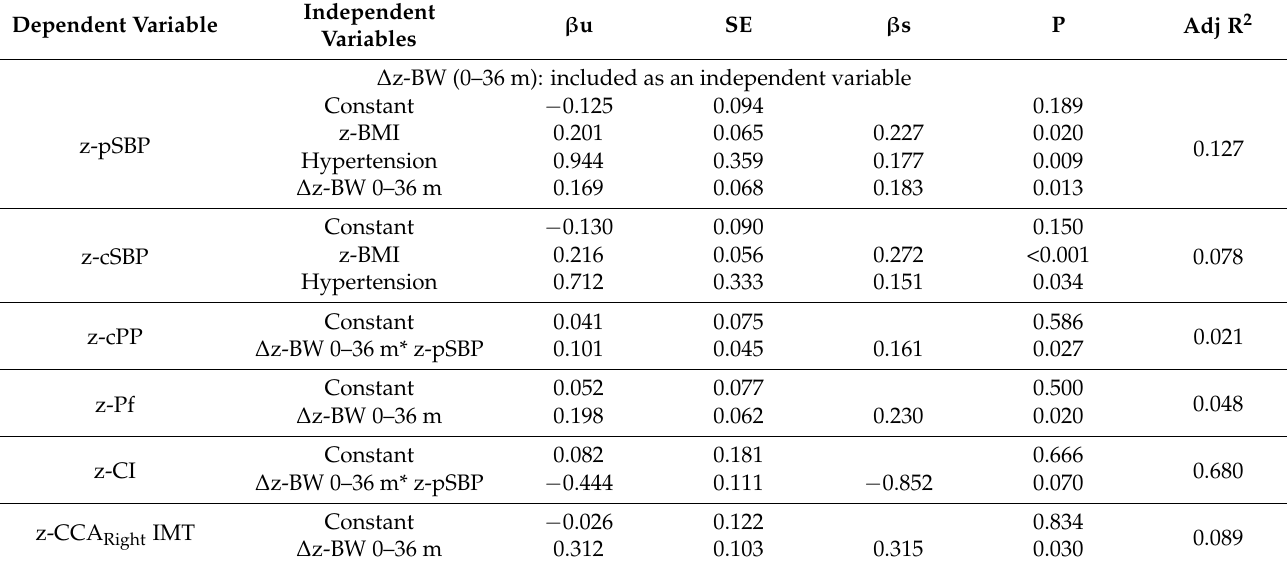
Table 7. MLR analysis between arterial parameter z-scores at age 6 y (dependent variables) and anthropometric measures and CRFs (independent